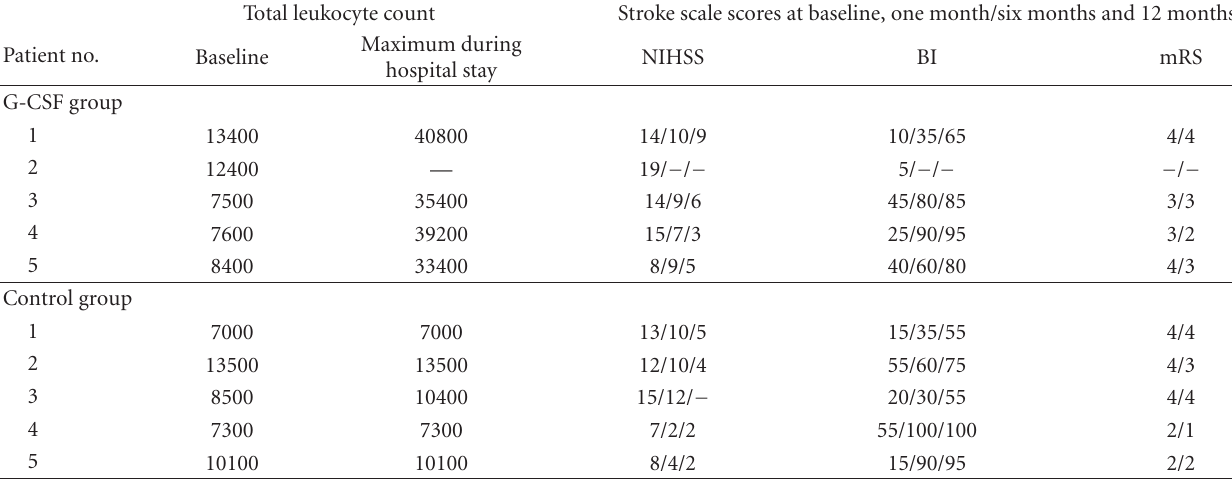
Table 4: Leukocyte counts at baseline and maximum count during hospital stay and clinical score during baseline one month, six months, and 12